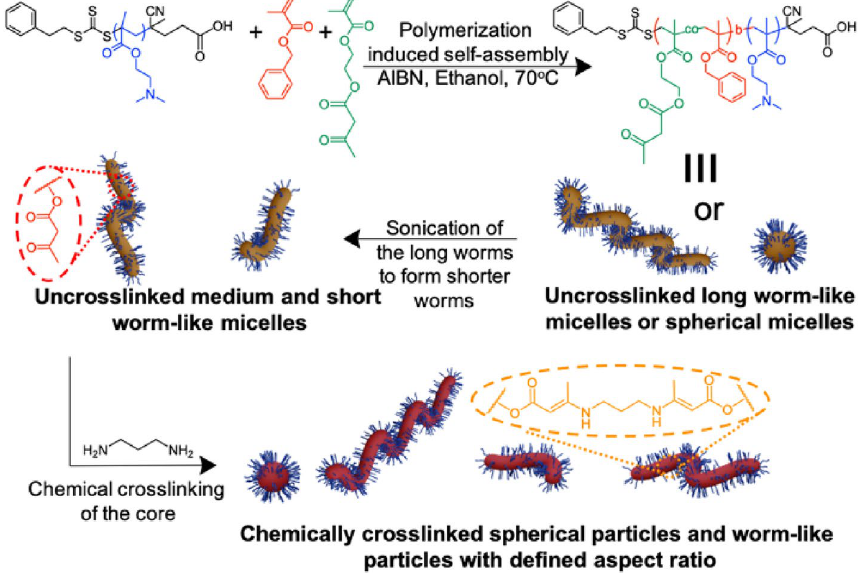
Figure 1. Synthesis of core crosslinked stable block copolymer nanoparticles through polymerization induced self-assembly, sonication and post-polymerization crosslinking. First, a macro-CTA composed of poly(2- (dimethylamino)ethyl methacrylate is extended by the polymerization of a mixture of benzyl methacrylate and 2-(methacryloyloxy)ethyl acetoacetate. Controlling the length of the second block leads to the formation of either spherical micelles or long worm-like micelles. Then, ultrasonication cuts the long worm-like micelles into smaller worm micelles. Finally, the acetoacetate groups present in the core of the micelles are crosslinked by the addition of diaminopropane to yield the chemically crosslinked